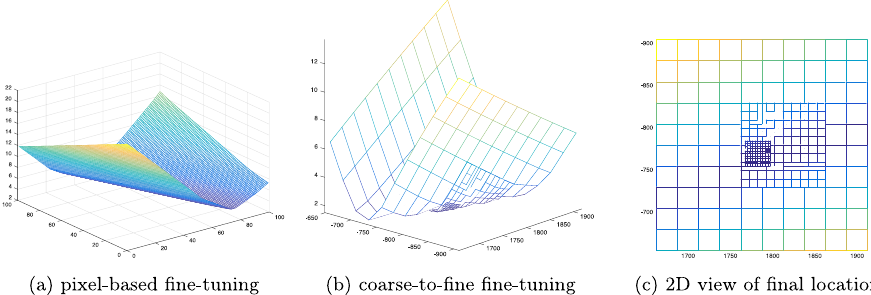
Figure 11. A coarse-to-fine fine-tuning comparison. The vertical axis shows the accumulated error value. Grid color from warm to cold represents the error from high to low. ( a ) Traditional pixel-based fine-tuning, covering − 50 ∼ 50 pixels on the row and column with 100 2 calculation times; ( b ) The proposed coarse-to-fine approach, covering − 250 ∼ 250 pixels on the row and column with 4 × 10 2 calculation times; ( c ) A two-dimensional (2D) view of each searching layer.